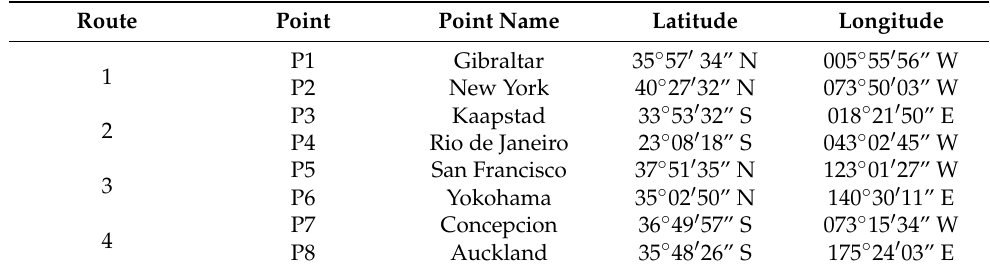
Table 1. Test position names and coordinates.